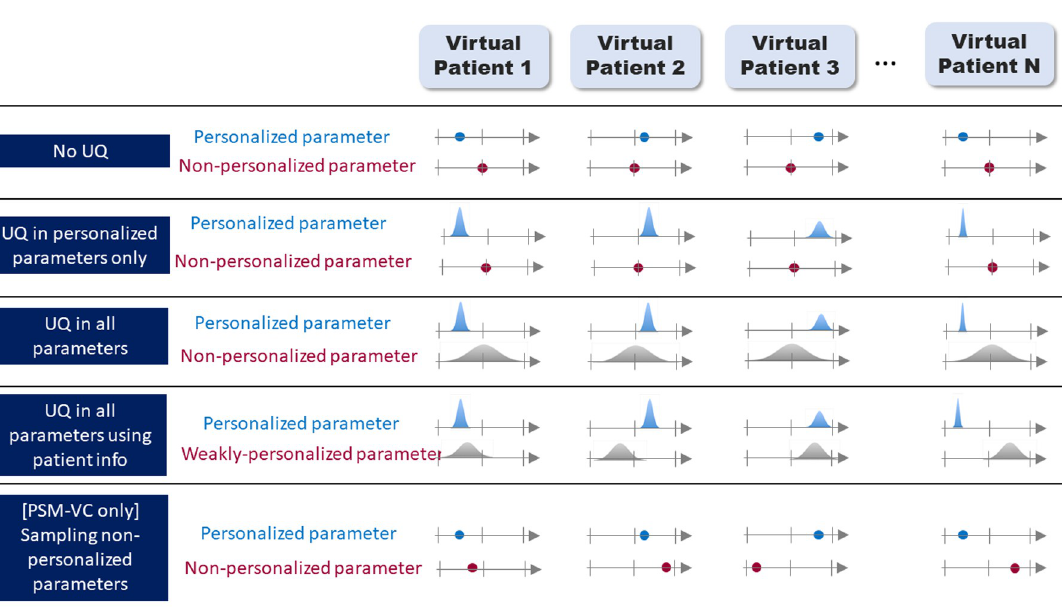
Fig 2. Five example UQ paradigms in patient-specific modeling. The N virtual patients could be N members of a virtual cohort in PSM-VC, or N new patients for a PSM-CT. In the first row, there is no UQ; the personalized parameter varies across the subjects, the non-personalized parameter is constant. In the second row, uncertainty in the personalized parameter (e.g., due to measurement error) is accounted for–represented here as a probability distribution, though other methods for accounting for uncertainty could be used. In the third row, uncertainty in the non-personalized parameter (e.g., due to population variability) is also accounted for. In the fourth row, some patient information is used to constrain the distributions for the ‘non-personalized’ parameters (e.g., if the parameter is known to differ between sexes). In the final row (PSM-VC only) the non-personalized parameter is randomly sampled in the cohort members, rather than taking the population average value for all patients. Other options are possible.